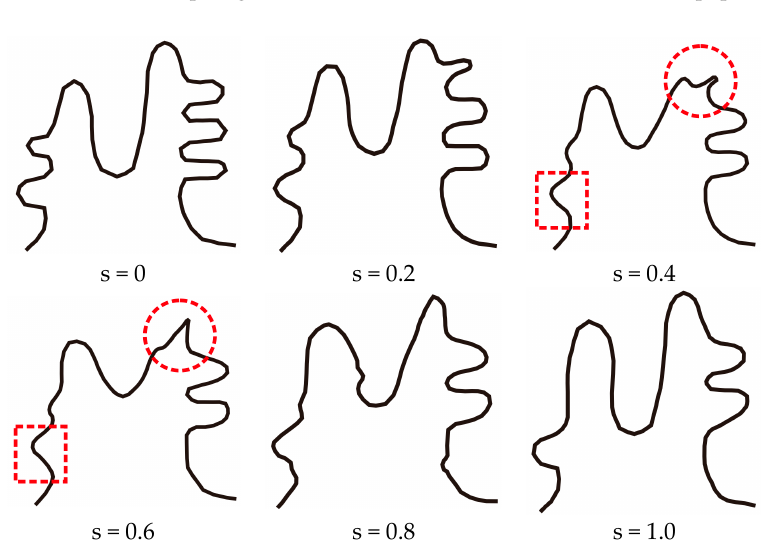
Figure 7. The morphing effect of naive linear interpolation.